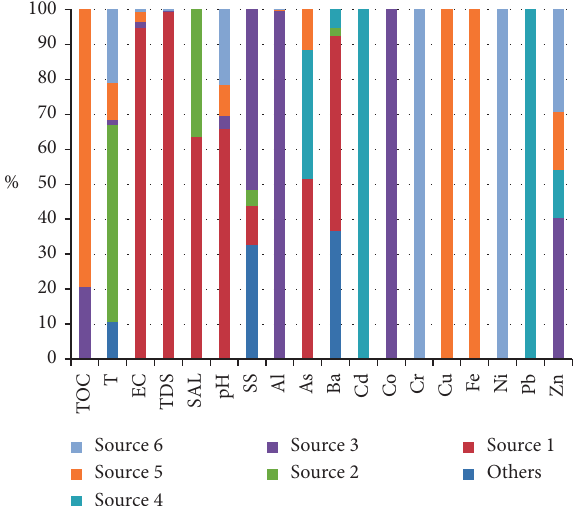
Figure 5: Concentration % for water quality parameters in